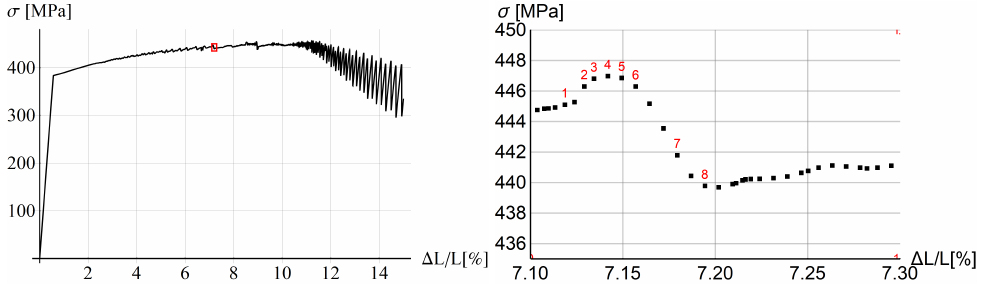
Figure 3. Stress vs. relative longitudinal displacement for rod benchmark: whole process ( left ) and one selected serration ( right ).